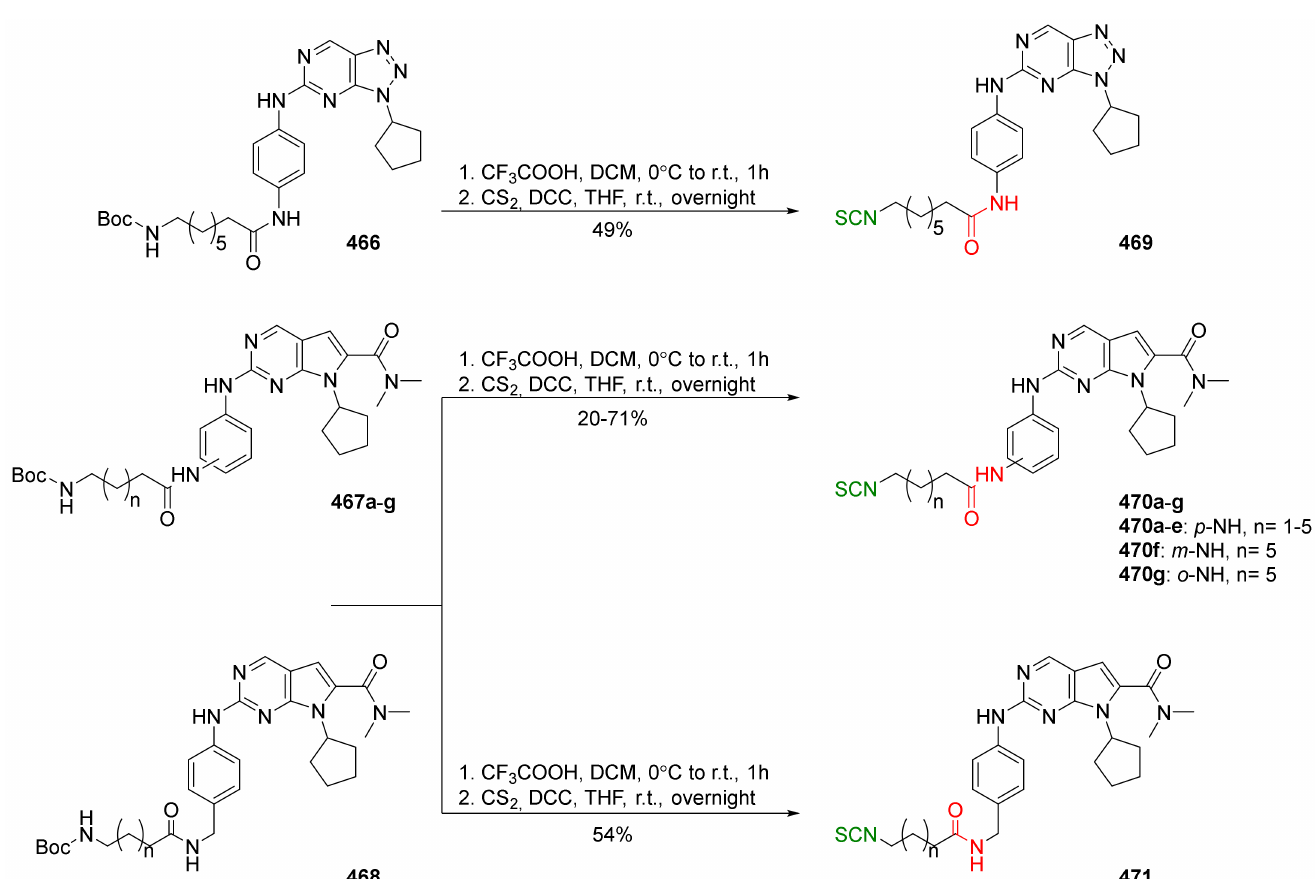
Figure 53. Synthesis of ITCs 469 , 470a – g , and 471